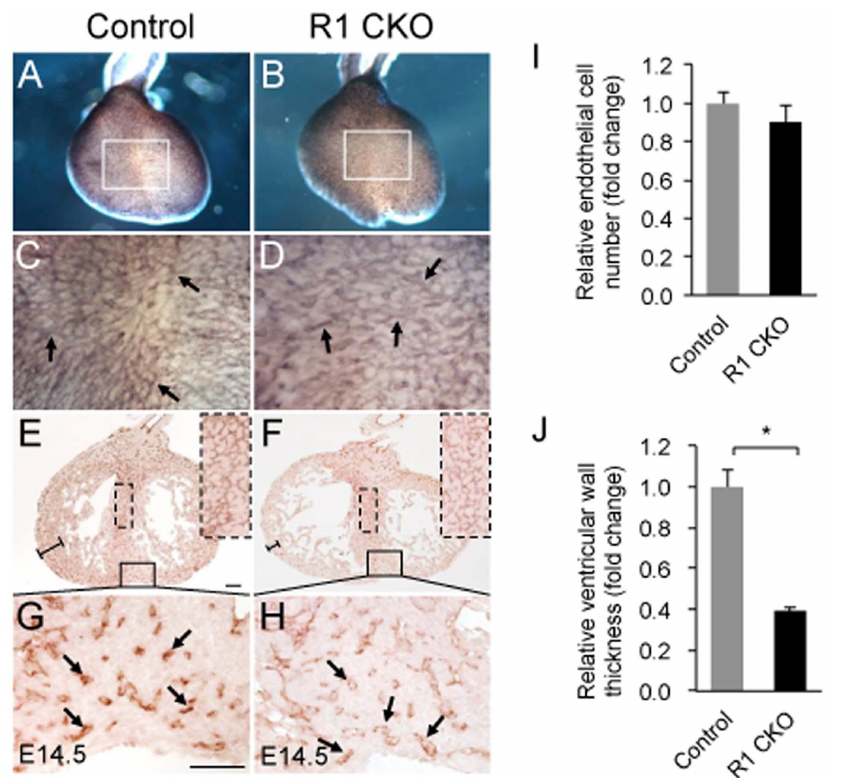
Figure 4. Endocardial Vegfr1 is not essential for late coronary development, but required for normal ventricular wall development. A-D, Images of wholemount Pecam1 stained E14.5 hearts showing comparable coronary vasculatures (arrows indicating individual vessels) between the control and R1 CKO hearts. E-H, Images of Pecam1 stained frontal sections of E14.5 hearts showing comparable coronary vasculatures between the control and R1 CKO hearts (arrows indicating individual vessels). Note that the CKO hearts have a thin compact myocardium. Scale bar =50 m m. I, Quantitative analysis showing comparable numbers of coronary endothelial cells between E14.5 control and R1 CKO hearts. n =3 individual hearts, 5 comparable sections per heart, error bars=SD. J, Quantitative analysis showing that the thickness of the compact myocardium is significantly reduced in the R1 CKO embryos compared to the control embryo. n =3 individual hearts; 5 comparable sections per heart. * p , 0.05, error bars=SD.